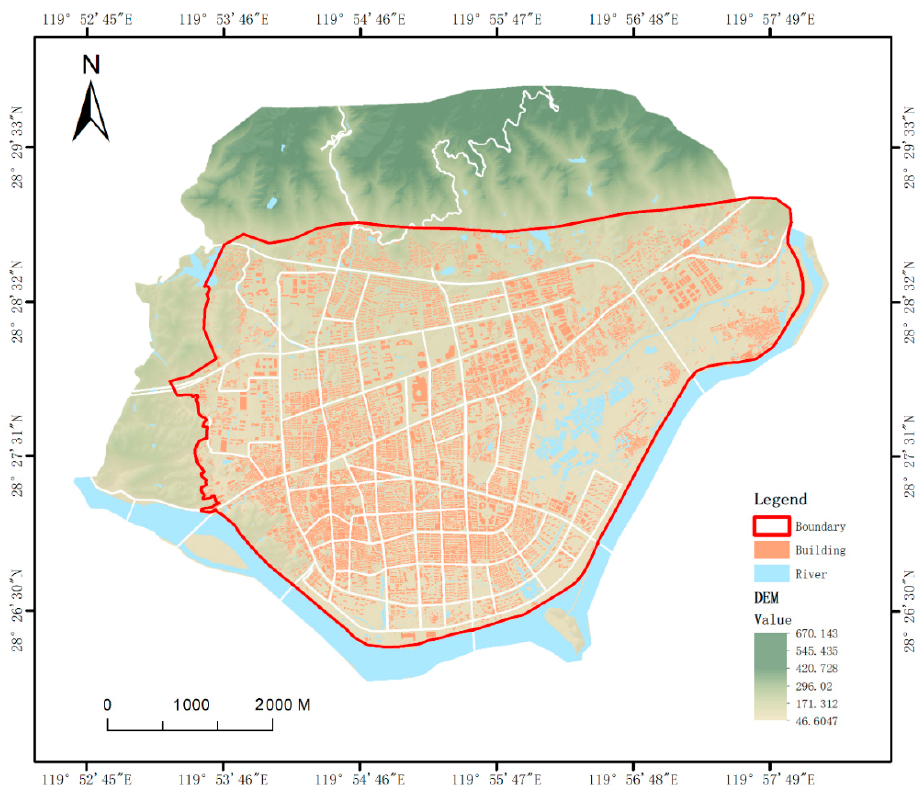
Figure 1. Map of the study area.